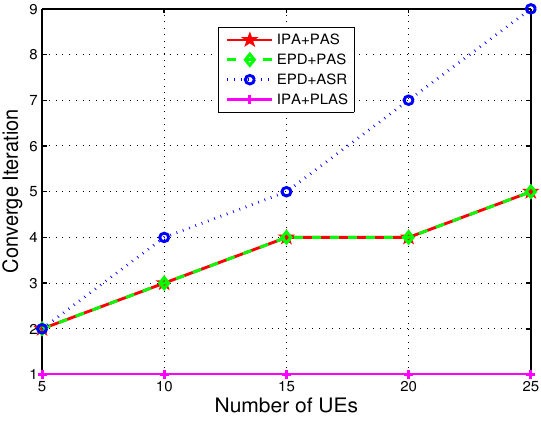
Figure 9. Iteration of different schemes in stage